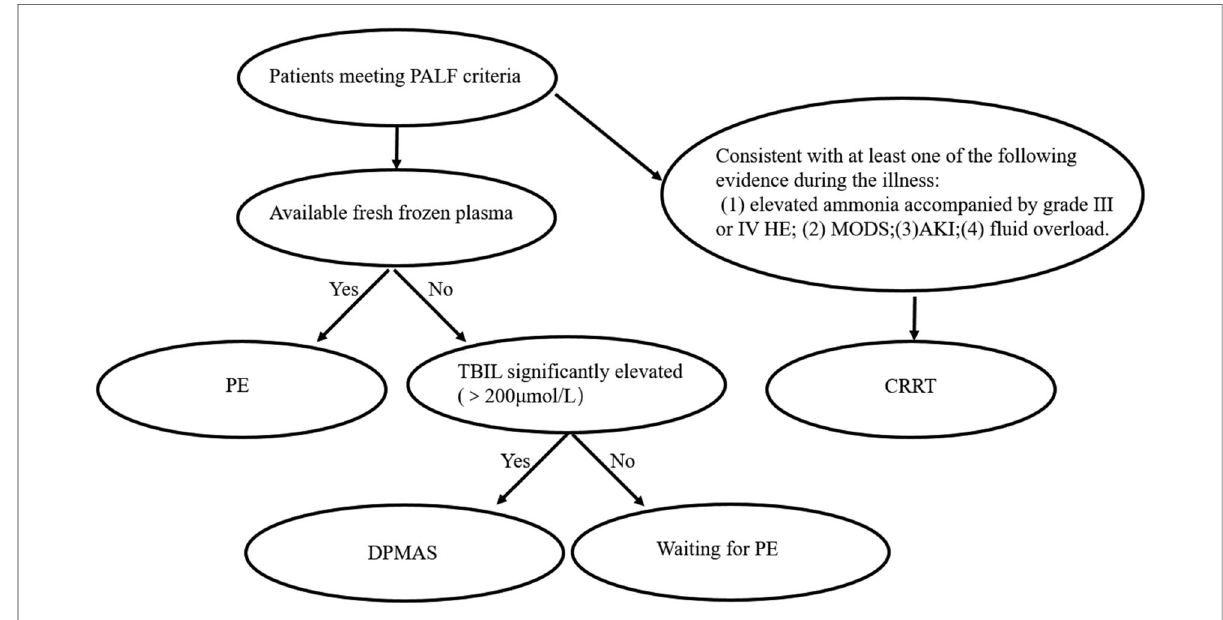
FIGURE 2 A general procedure for selecting ALSS modalities for patients with